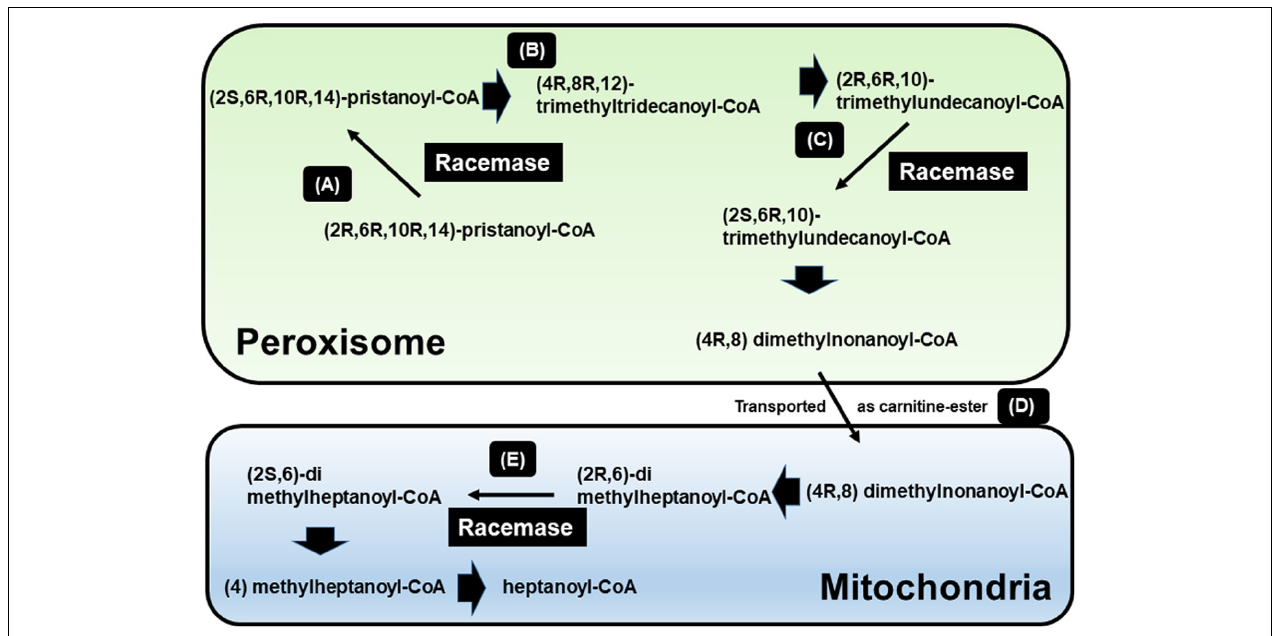
FIGURE 1 | β -oxidation of pristanic acid and racemase activity in peroxisomes and mitochondria. (A) (2R,6R,10R,14)-pristanoyl-CoA exist the half of natural pristanoyl-CoA. The limited action of branched-chain acyl-CoA oxidase (first enzyme in β -oxidation), (R)-stereoisomer should be changed to its (S)-stereoisomer by racemase. (B) The intermediate (4R,8R,12) trimethyltridecanoyl-CoA can be further β -oxidized to (2R,6R,10)-trimethylundecanoyl-CoA. (C) Again, the resulting (R)-acyl-CoA then also need to be changed to (S)-stereoisomer by racemase. (D) After another β -oxidation occurs, (4R,8)-dimethylnonanoyl-CoA is moved to mitochondria from peroxisome via acyl-carnitine ester formation. (E) After another β -oxidation occurs, the intermediate (2R,6)-dimethylheptanoyl-CoA also need to be (S)-stereoisomer by racemase [adapted from Ferdinandusse et al. (2000b)].